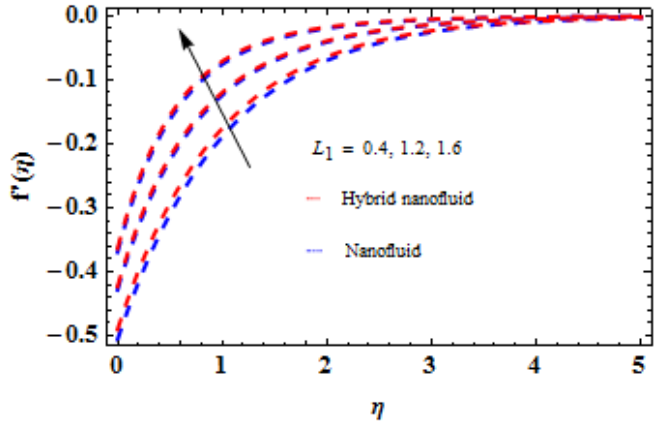
Figure 15. Influence of 𝐿 0 via 𝑓′(𝜂).